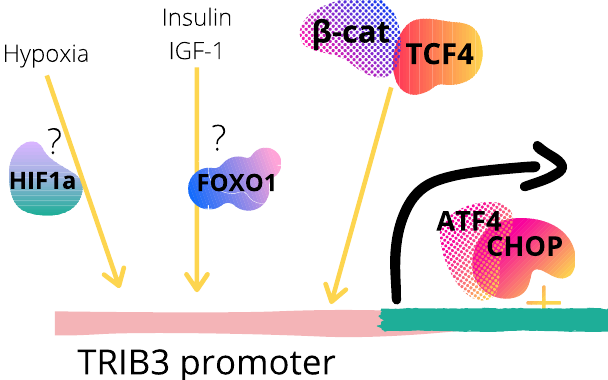
Figure 2. TRIB3 upstream regulation in colorectal cancer. Proposed mechanisms regarding TRIB3 regulation at the promoter level based on references [63,67,79,85,86] are shown. TRIB3 is a transcrip- tional target of the ATF4–CHOP [87] and β -catenin–TCF4 [79] complexes through direct binding at specific sites at TRIB3 genomic sequence, localized at +201 to +312 and at − 12 to − 3, respectively. TRIB3 is proposed to be positively or negatively regulated by HIF1 α or FOXO1 at the transcriptional level, respectively, in response to specific stimuli that modulate transcription factors merged (TF) activity such as hypoxia or feeding signals. TF are depicted as random elements from Canva